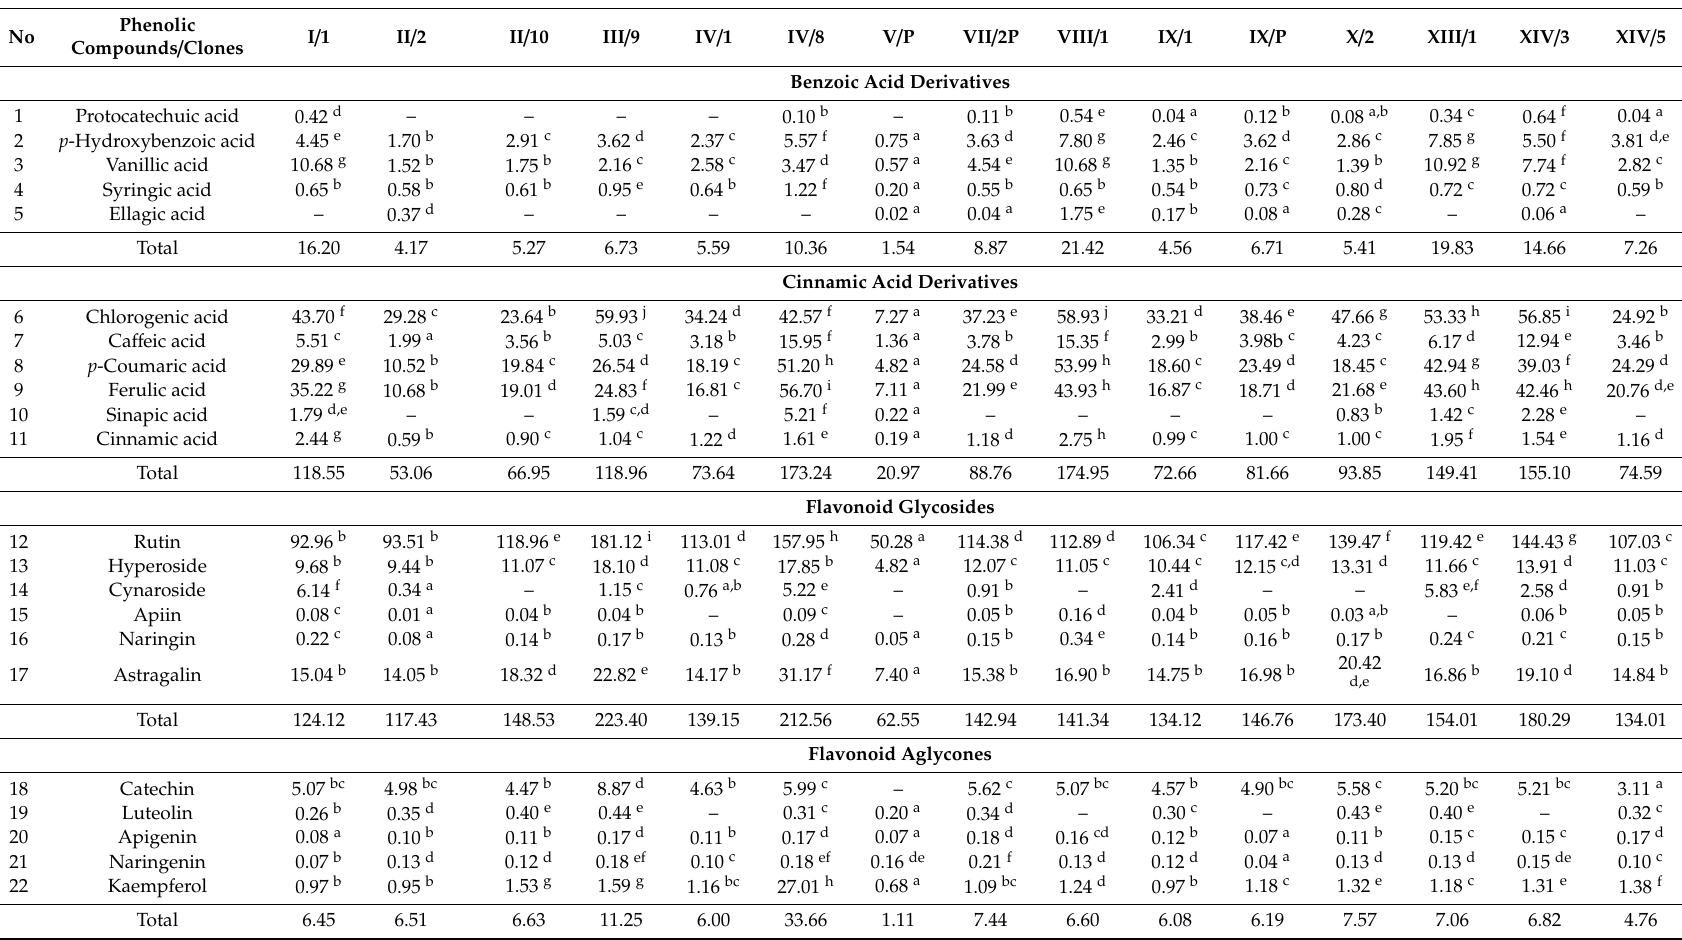
Table 4. The average (2015 and 2016) contents of phenolic compounds (mg / kg), in pollen of 15 ‘Oblaˇcinska’ sour cherry